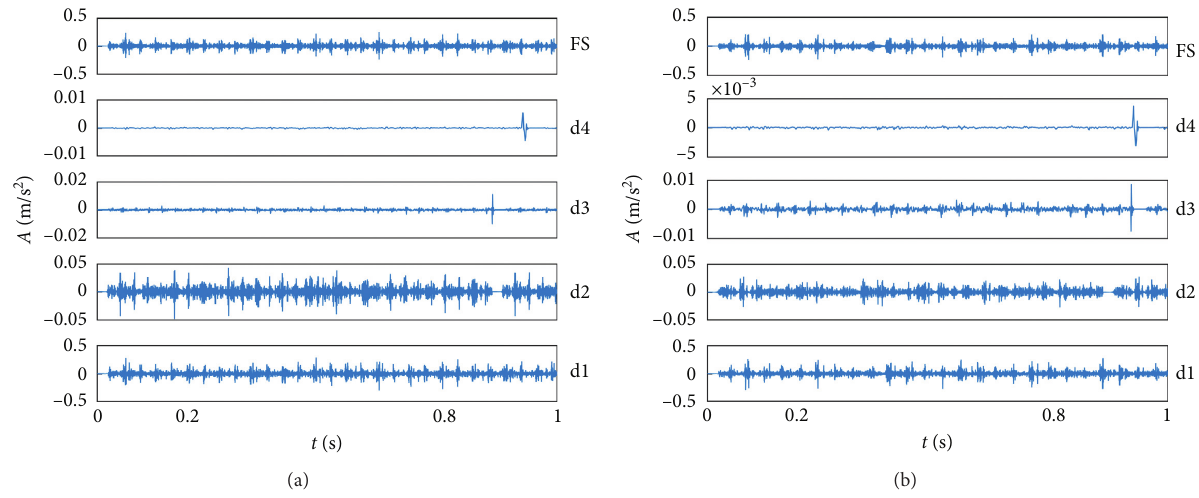
Figure 19: The results of the experimental signal processed by wavelet decomposition. (a) Normal state. (b) Single-cylinder misfire fault